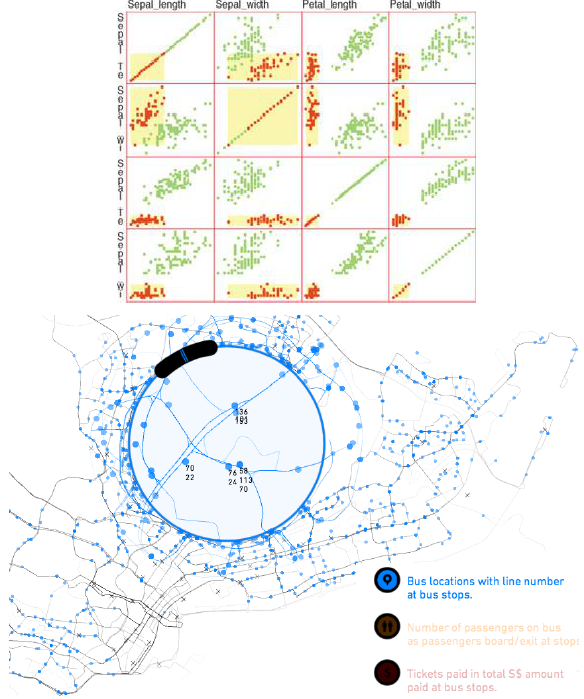
Figure 7. Interactive Linking/Brushing (upper) (Ward, 2009) and Distortion (bottom) (URL-3) Examples